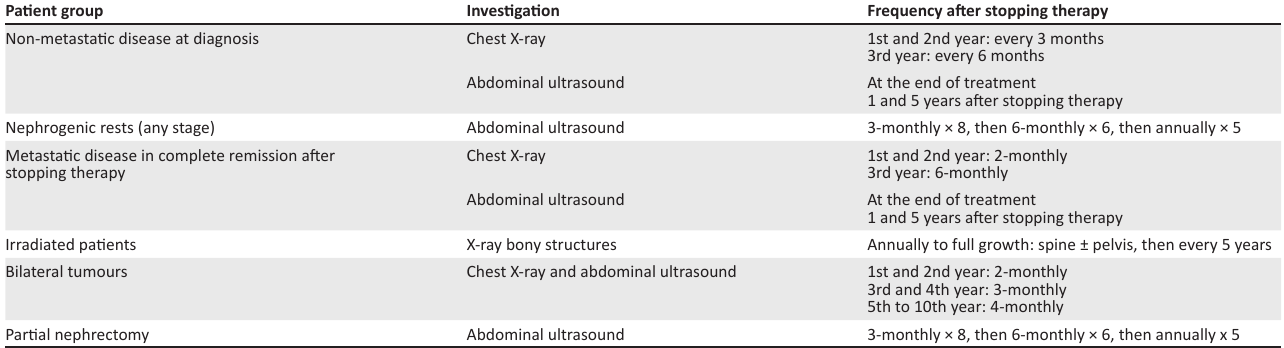
TABLE 2: SIOP imaging recommendations for long-term follow-up of children with renal neoplasms. 6 Patient group